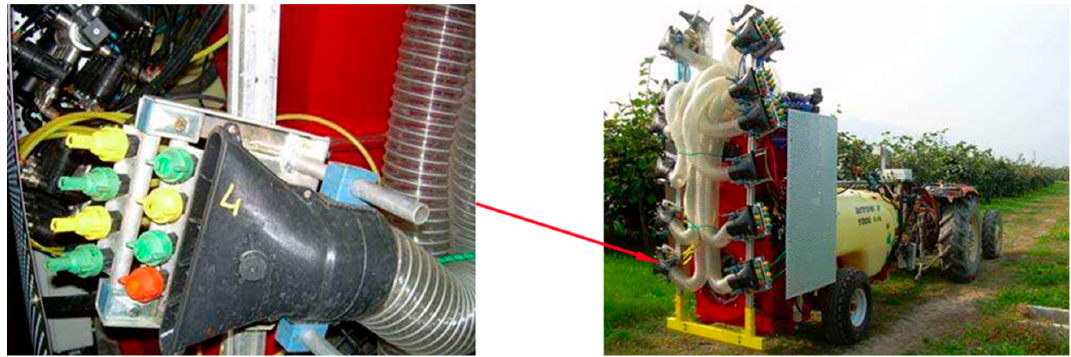
Figure 10. Variable-nozzle-type sprayer prototype [15].